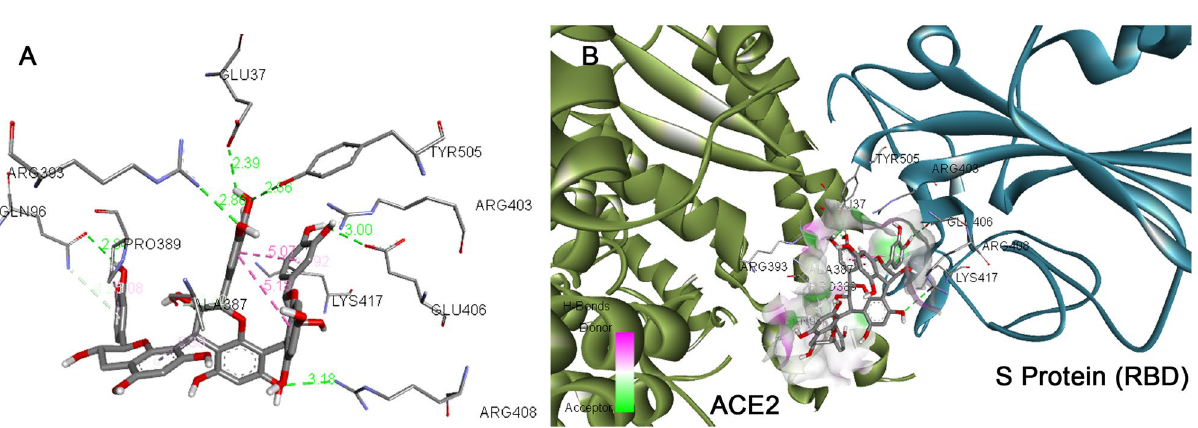
Figure 6. Docked pose of catechin in the interface of RBD/ACE2-complex. ( A ) Participating amino acids in the interaction of catechin and RBD/ACE2-complex, ( B ) Several bonds involved in the interaction between catechin and RBD/ACE2-complex. This figure was produced using Discovery Studio Visualizer (http://accel rys.com/ produ cts/colla borat ive-scien ce/biovi a-disco very-studi o/visua lizat ion-downl oad.php).